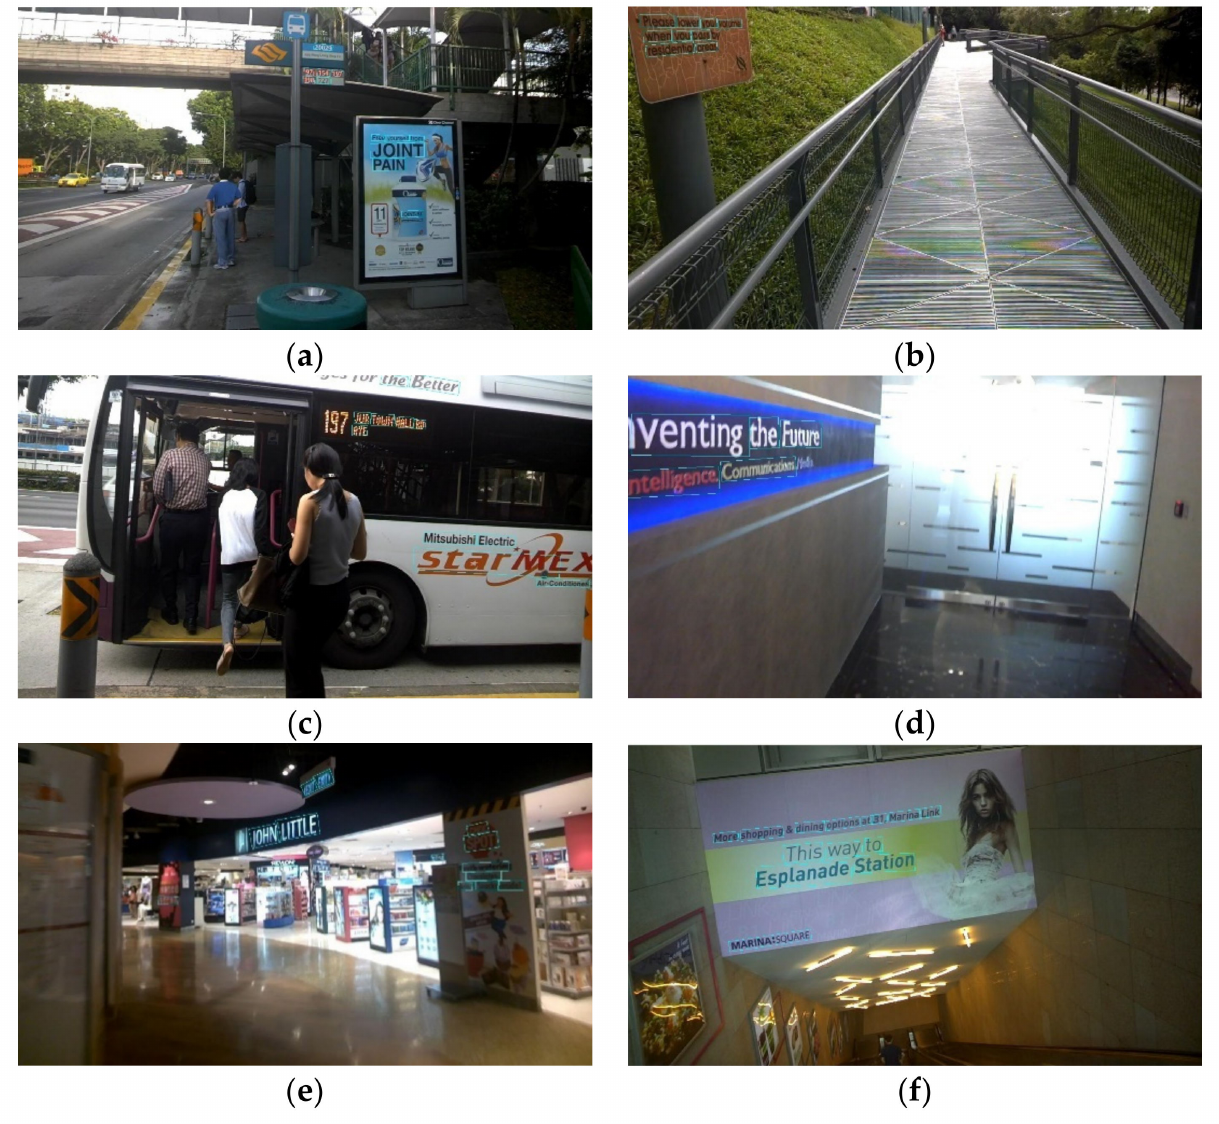
Figure 17. Oblique text detection results in natural